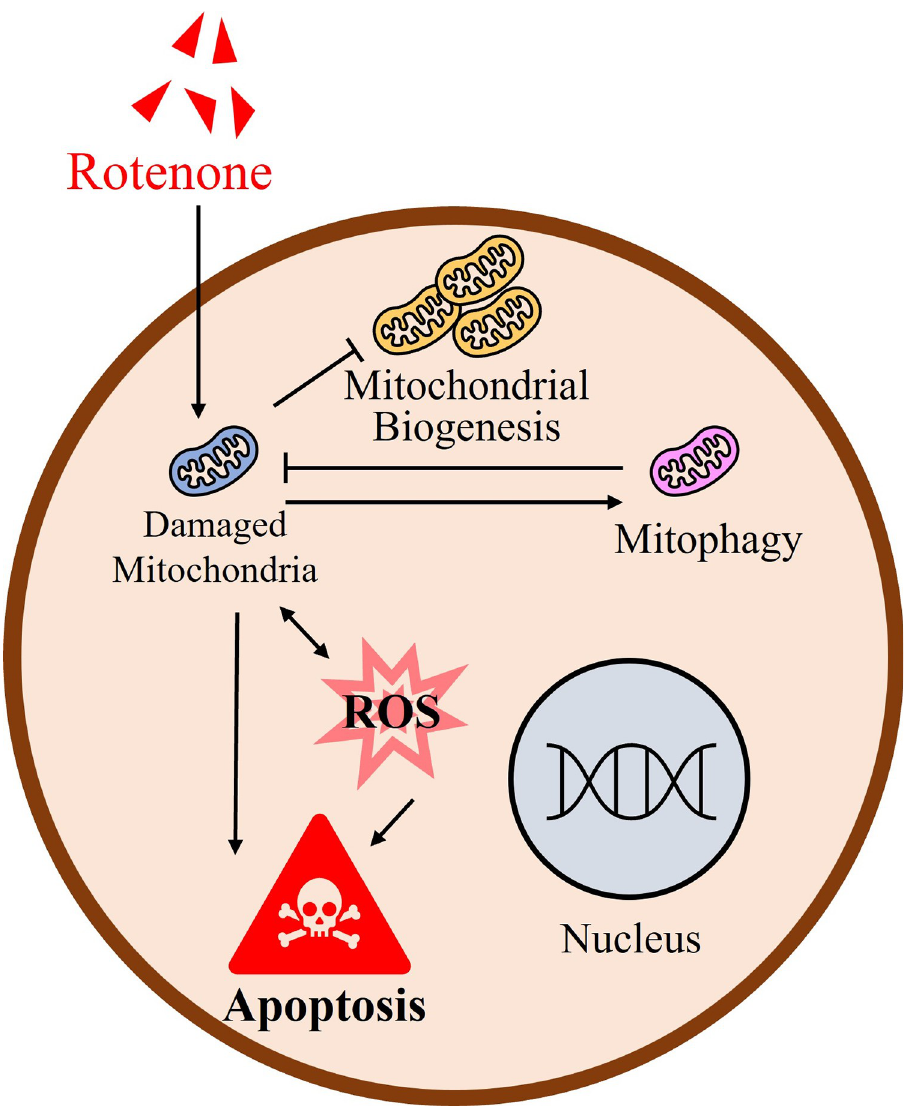
Fig 7. Rotenone exposure disturbs meiotic maturation by inducing mitochondrial dysfunction in porcine oocytes. Rotenone exposure causes mitochondrial dysfunction, and damaged mitochondria inhibit mitochondrial biosynthesis. Damaged mitochondria trigger mitophagy, and mitophagy can mitigate mitochondrial damage. Damaged mitochondria induce ROS, eventually leading to apoptosis.